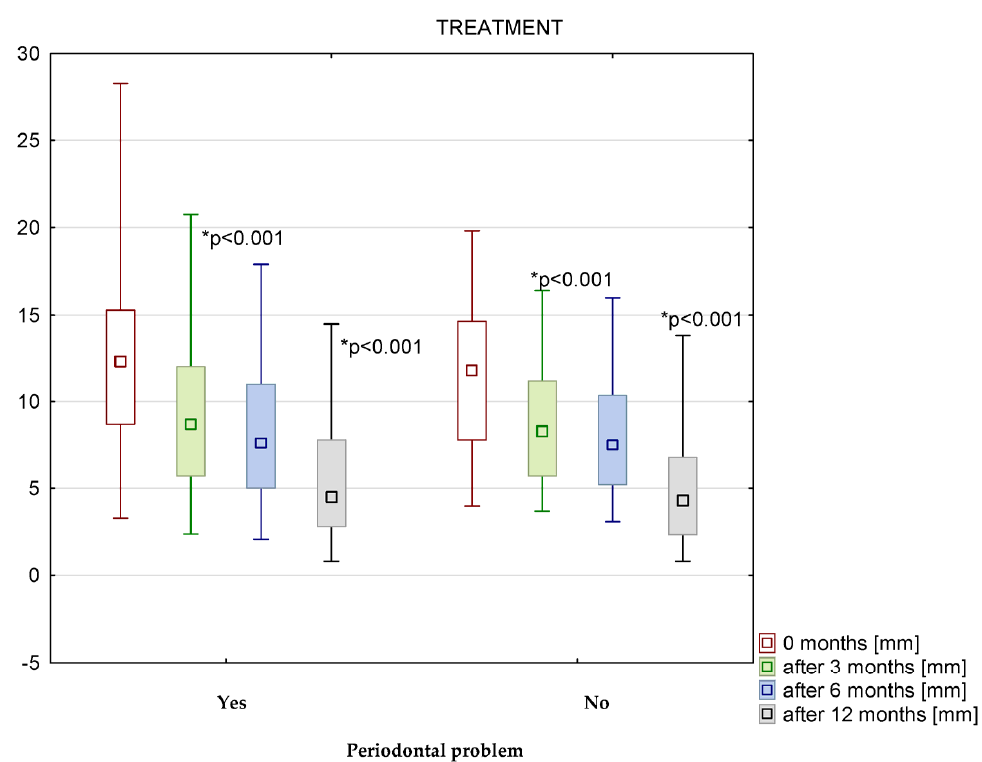
Figure 3. The thickness of Schneiderian membrane in mm from 0 to 12 months after primary treatment with and without periodontal problems.